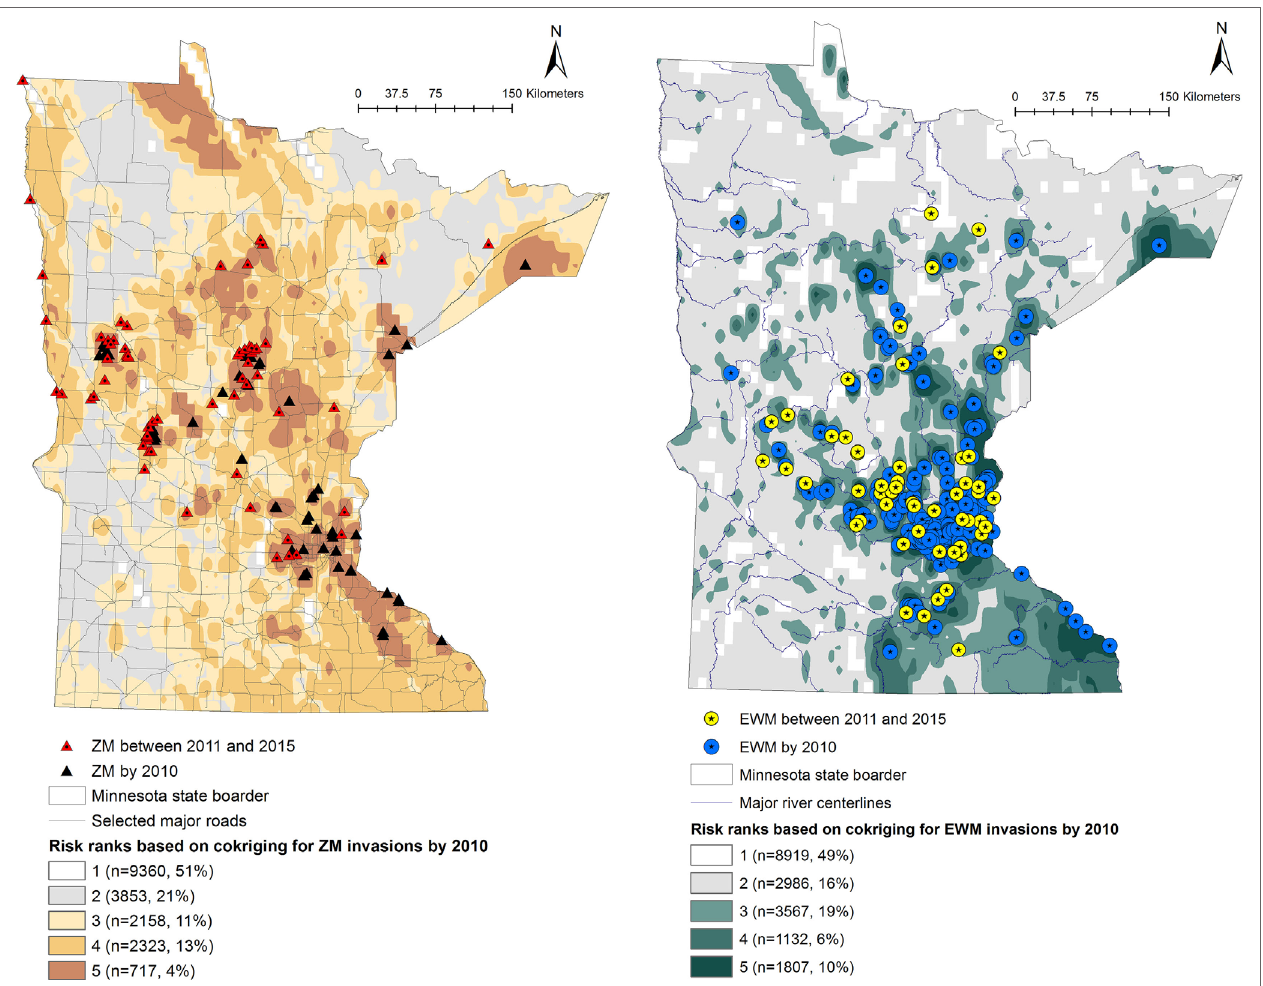
FigUre 1 | Co-kriging model outputs illustrating the probability of introduction of zebra mussels (ZMs) and Eurasian watermilfoil (EWM) to Minnesota waterbodies, for the invasions as of 2010. The risk classes 1 through 5 indicate the intensity of the probability of introduction, where class 5 represents a high probability of ZM or EWM introduction. The number of waterbodies under each category and as a percentage of the total waterbodies ( n = 18,411) is